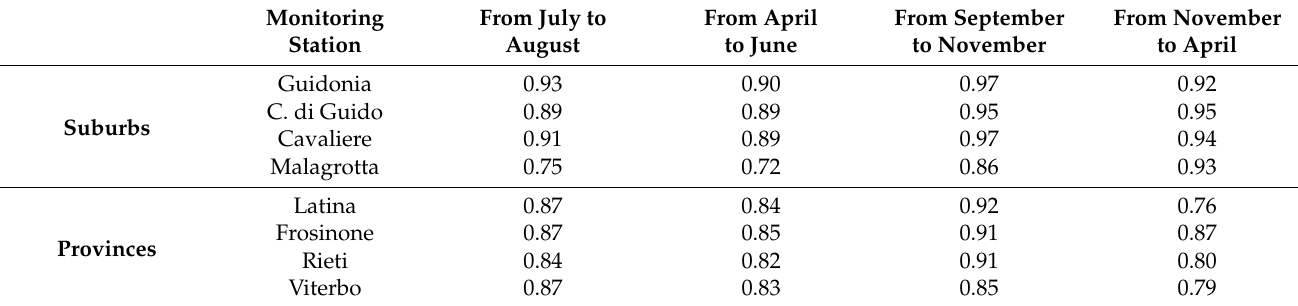
Table 12. Cross-correlation values between Roma Green Band and suburbs or province stations of [PM 2.5 ] in 2015. Monitoring Station